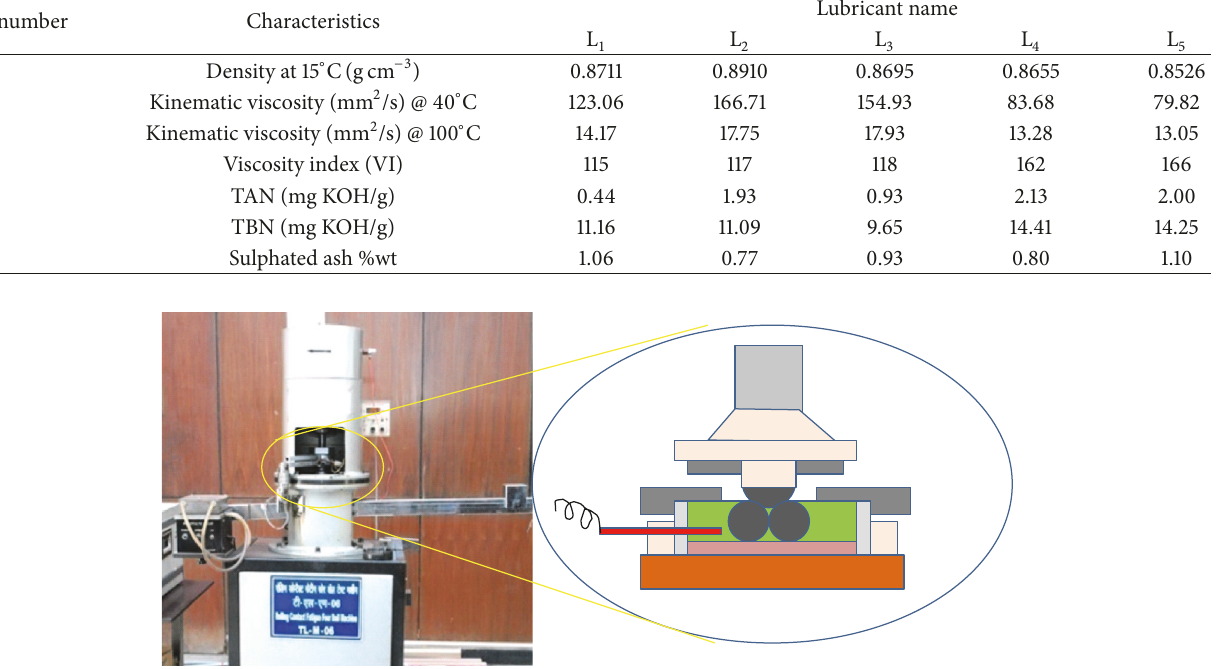
Figure 2: Four-ball tribotester (FBT).